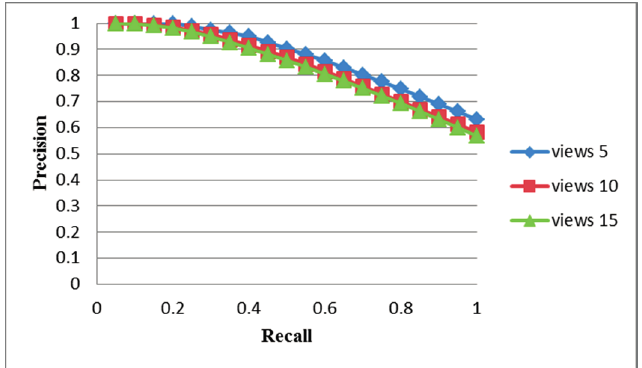
Figure 9. Precision-recall curves of the proposed method for three numbers of optimum views, 5, 10 and 15.